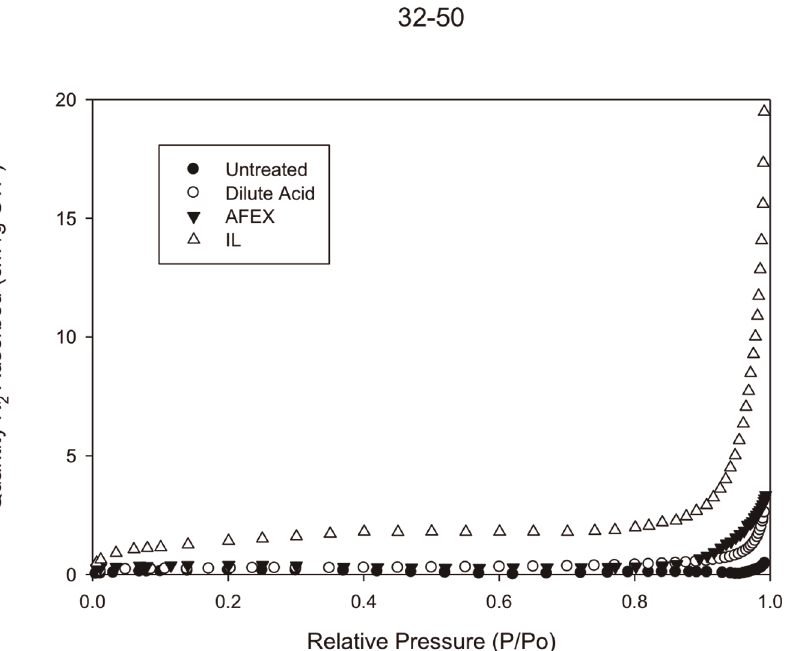
Figure 2. Representative plot for nitrogen porosimetry experiments. Nitrogen adsorption isotherms are shown for 32–50 mesh samples of untreated and pretreated switchgrass.